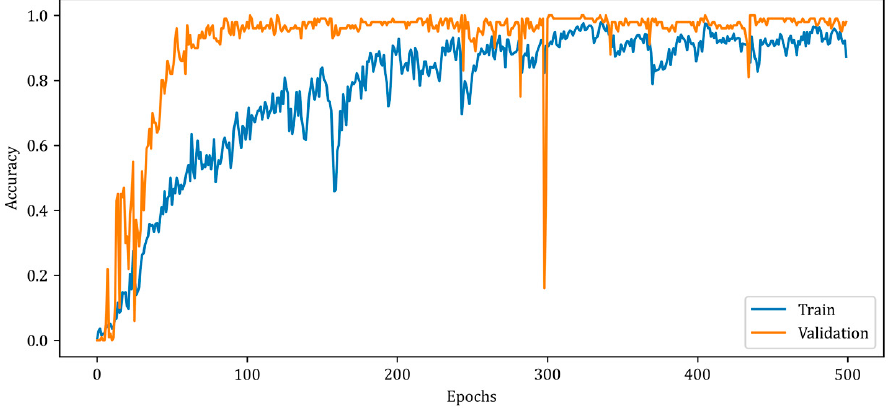
Figure 9. Accuracy curves for training and validation phases of the proposed RV-MWINet model.